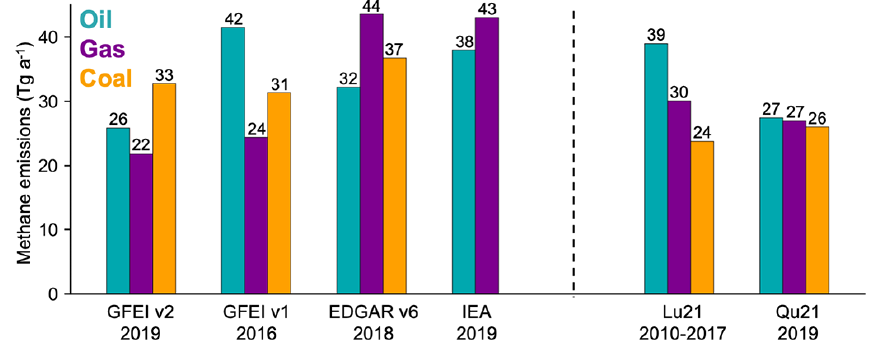
Figure 5. Global estimates of oil, gas, and coal methane emissions. The left bars show bottom-up inventories while the right bars show inversion results from Lu et al. (2021; Lu21) and Qu et al. (2021;